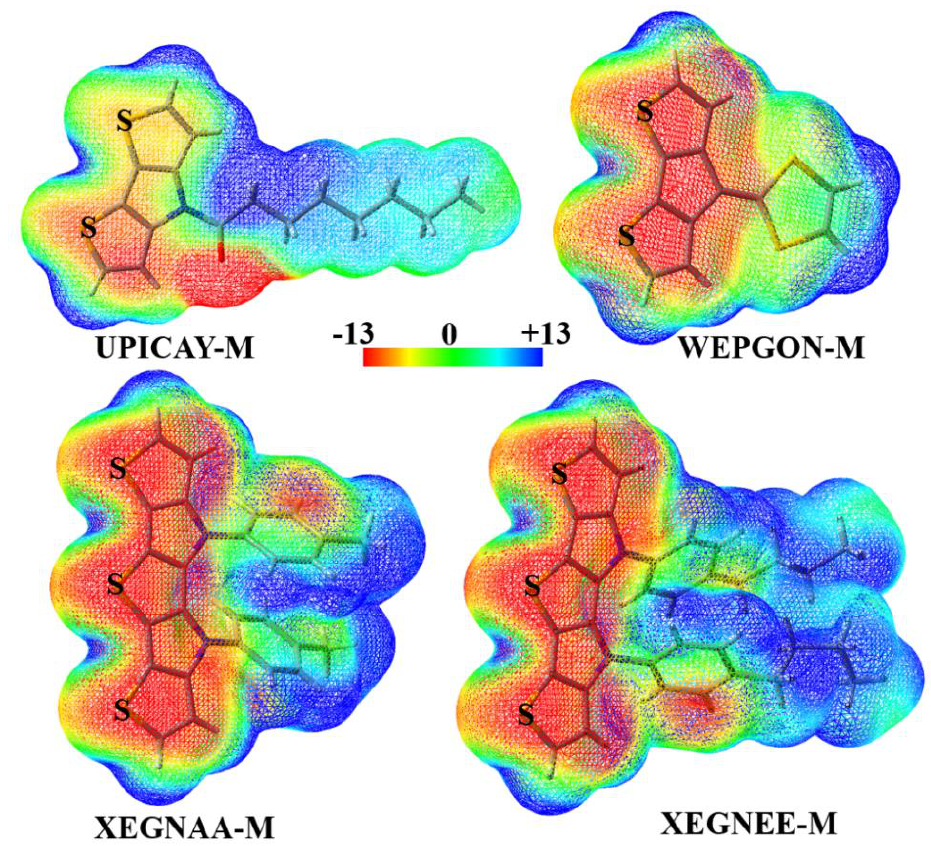
Figure 4. The molecular electrostatic potential maps of the monomers UPICAY-M, WEPGON-M, XEGNAA-M and XEGNEE-M. The color scale is in kcal/mol. XEGNAA-M and XEGNEE-M. The color scale is in